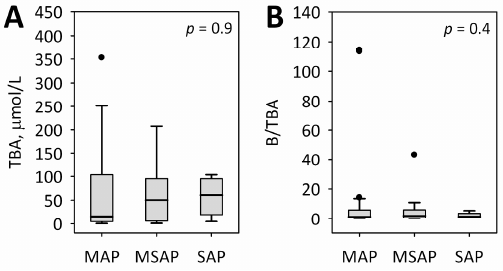
Figure 2. TBA serum concentrations ( A ); and B/TBA ratio ( B ) at 24 h from the onset of AP symptoms among patients with MAP, MSAP, and SAP, irrespective of etiology. Data are shown as median, interquartile range (box), non-outlier range (whiskers), and outliers (dots). Table 2. Statistically significant correlations between serum concentrations of TBA, B/TBA ratio, and the selected laboratory markers at 24 h from the onset of acute pancreatitis.